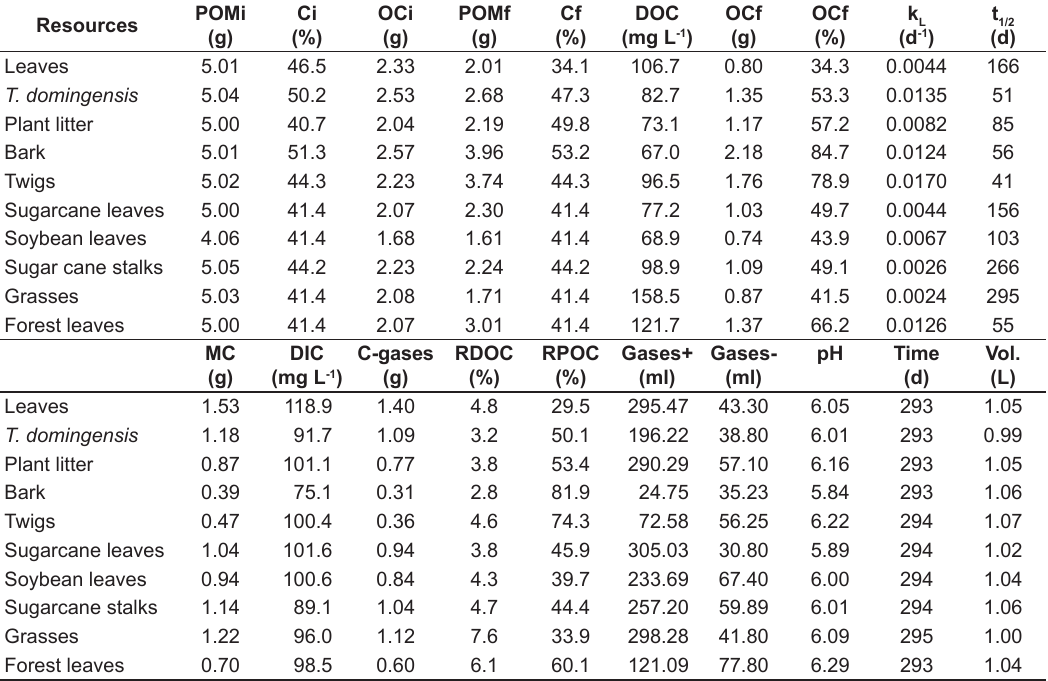
Table 2. Initial and final amounts of resources, carbon budget and experimental parameters derived from anaerobic decomposition of the different plant